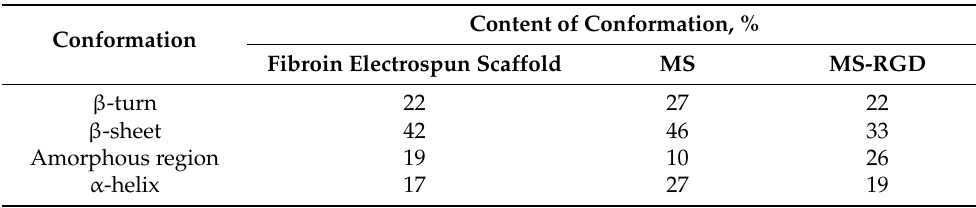
Table 2. Deconvolution of the second derivative and the spectrum of scaffolds in the region of amide I depending on the composition of proteins.